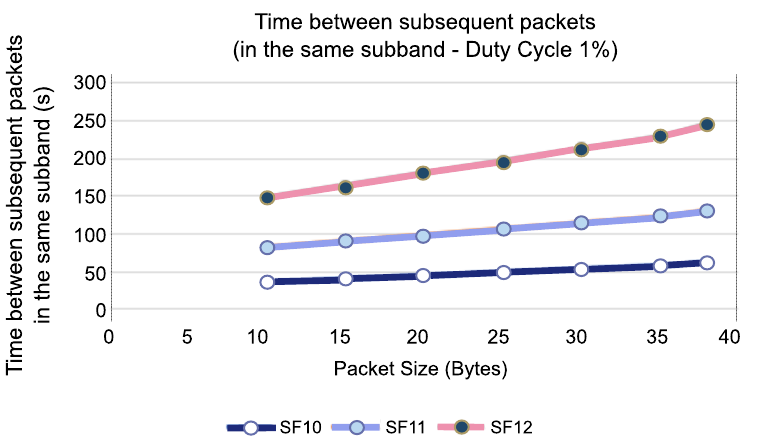
Figure 10. Theoretical time-on-air (ms) for different tested SF